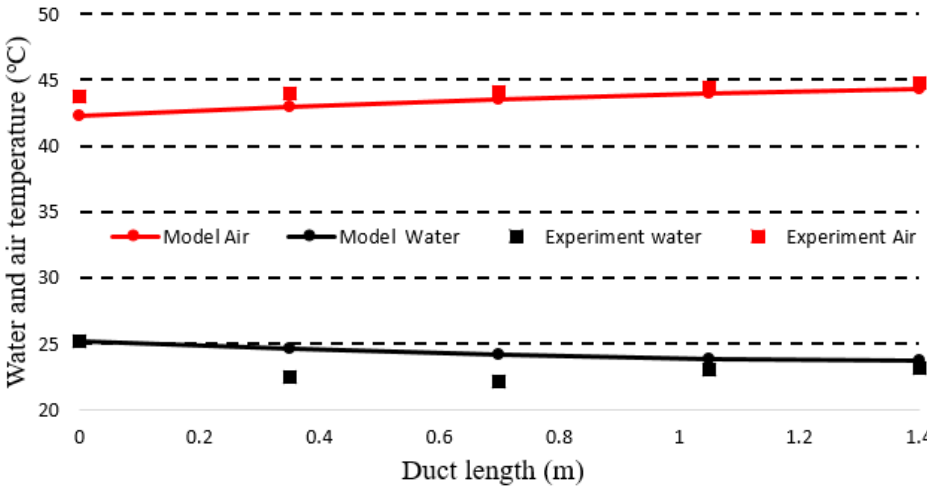
Figure 14. Experimental and simulated air and water temperatures on 20 June at 14:05.